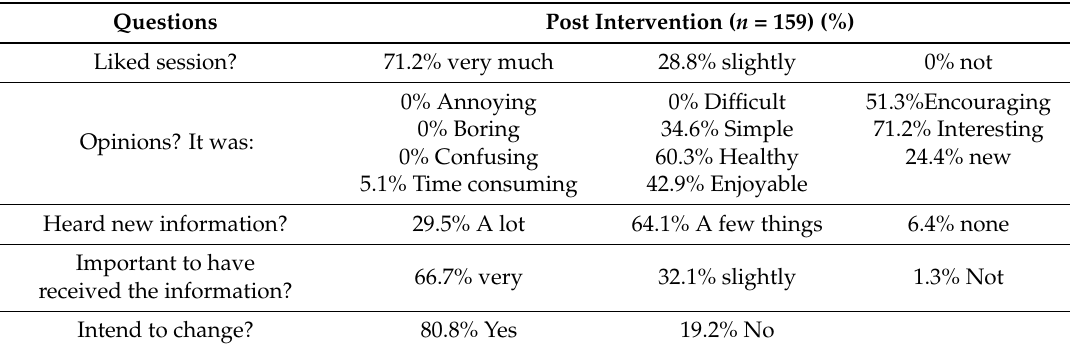
Table 6. Opinions on the Nutrition Education